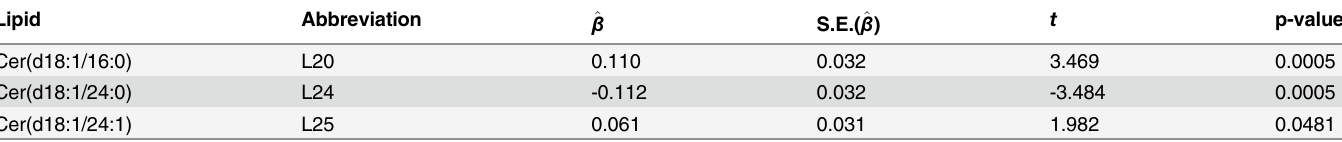
Table 4. The three fully observed lipids having significantly different mean concentrations between case and control groups by the marginal